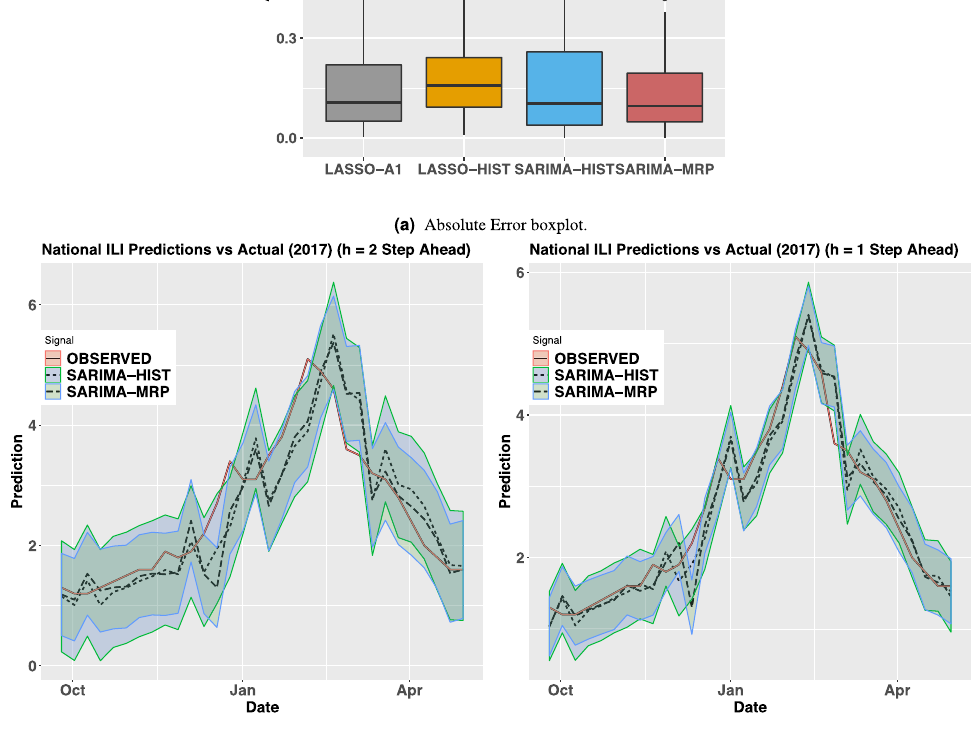
Fig. 2 National tracking model performance metrics. a Absolute error boxplot. b h = 2-step predictions. c h = 1-step predictions. a Box and Whisker plot of the absolute error of multiple model predictions based on the national percent of ILI visits based on CDC data ( T = 123 weeks). Horizontal line is median, boxes indicate 25% and 75% quantiles, and whiskers extend no more than 1.5 the length of each box. b / c The x -axis depicts the 2017 date and the y -axis depicts the predicted/true national percent of ILI visits per CDC data. Solid line is the actual CDC ILI visits and the dotted lines are point forecasts based on the SARIMA-HIST and SARIMA-MRP models along with upper and lower prediction intervals for both h = 1 and h = 2-steps ahead. ( T = 123